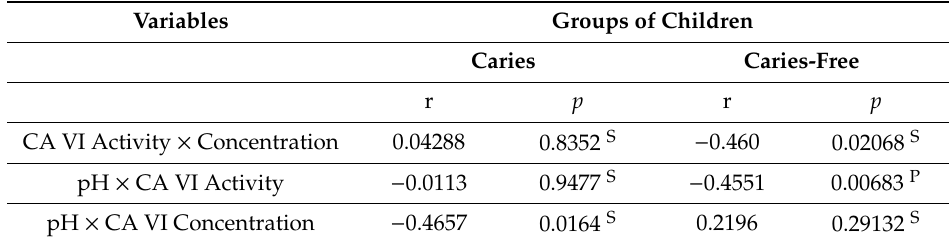
Table 1. Correlation between carbonic anhydrase (CA VI) activity and concentration, biofilm pH and CA VI activity, and biofilm pH and CA VI concentration in biofilm of children with caries and caries-free children. Values refer to Pearson and Spearman correlation coe ffi